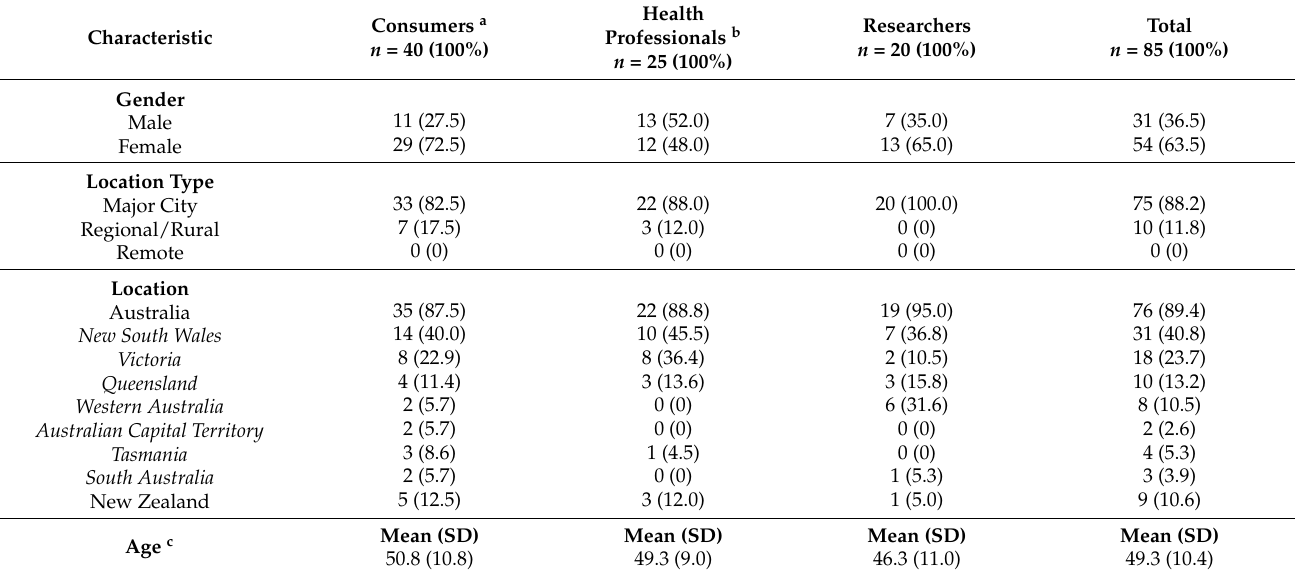
Table 1. Phase 1, Step 1 participant demographics for